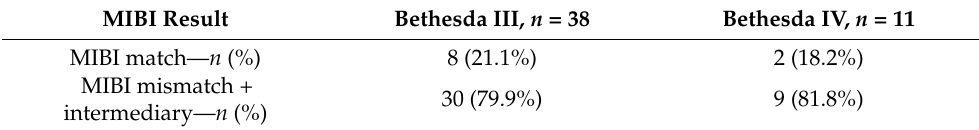
Table 2. The results of MIBI scintigraphy in indeterminate Bethesda III and IV nodules.